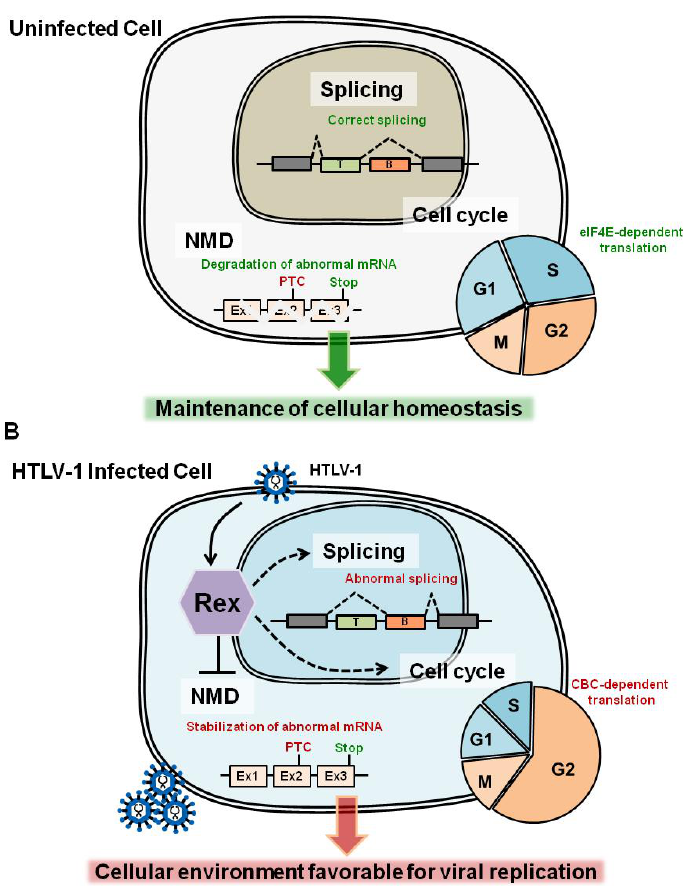
Figure 5. In this review, we focused on three cellular pathways, NMD, splicing machinery, and cell-cycle regulation, since we may expect that Rex interacts with these pathways to adjust the cellular environment suitable for the viral replication. ( A ) In the normal cells, the activities of NMD, splicing, and cell-cycle regulation are optimized to maintain the cellular homeostasis by eliminating PTC-containing harmful mRNAs, production of correctly spliced mRNAs encoding functional proteins, and adjusting the cell-cycle for n optimal cell proliferation rate and for effective eIF4E-dependent RNA translations, respectively; ( B ) In HTLV-1 infected cells, Rex inhibits NMD for stabilization of the viral genomic mRNA [32]. Additionally, based on previous reports and newly discovered aspects of Rex in our laboratory, we assume that Rex may suppress the activity of splicing machinery and may induce G2 arrest. These adjustments of host-cell mechanisms are favorable for the stabilization and translocation of viral mRNAs, as well as for selective translation of viral proteins for effective self-replication. On the other hand, suppression/alteration in these pathways may cause accumulation of abnormal PTC-containing mRNAs, thus harmful proteins; abnormal splicing patterns; deregulated cell proliferation; and suppression of eIF4E-dependent translation. Therefore, Rex-oriented tuning of the host cell environment may alter cellular homeostasis, and provide a basis for the pathogenesis of